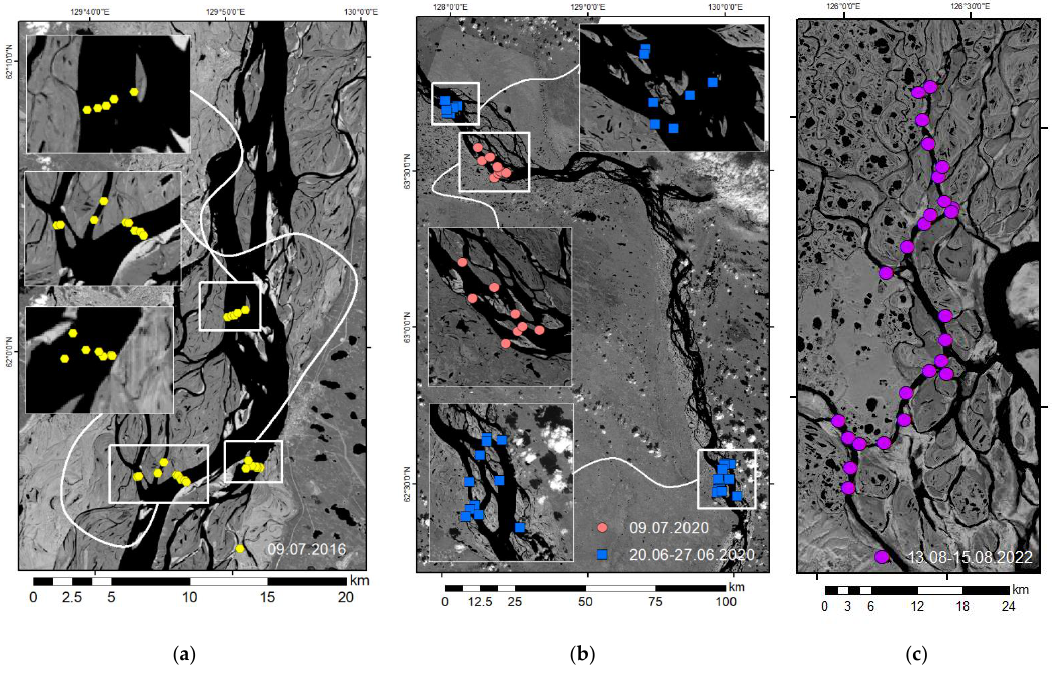
Figure 3. Locations of the field measurements of the SSC in the middle reach of the Lena River: 9 July 2016 ( a ), 20 June till 9 July 2020 ( b ) and in the Lena River delta: 13 – 15 August 2022 ( c ) used for regression model